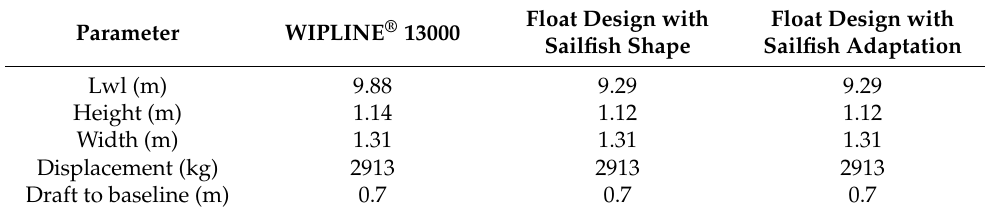
Table 1. Design specification of floats.